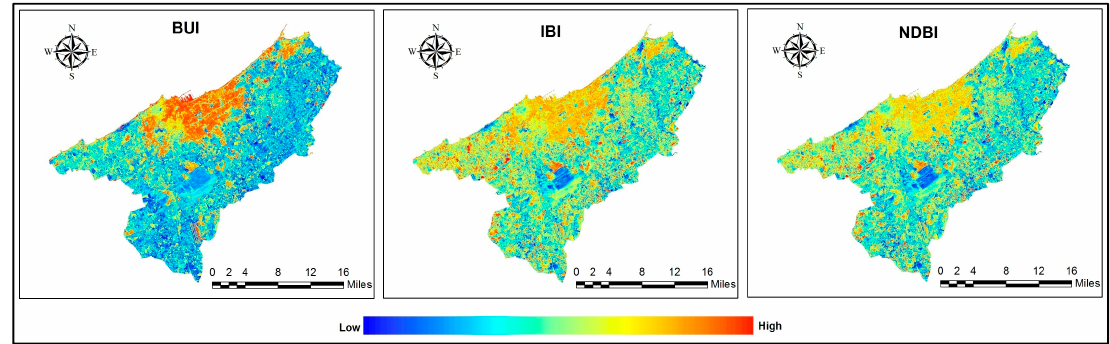
Figure 4 . Extraction of buildings using BUI, IBI and NDBI. Figure 4. Extraction of buildings using BUI, IBI and